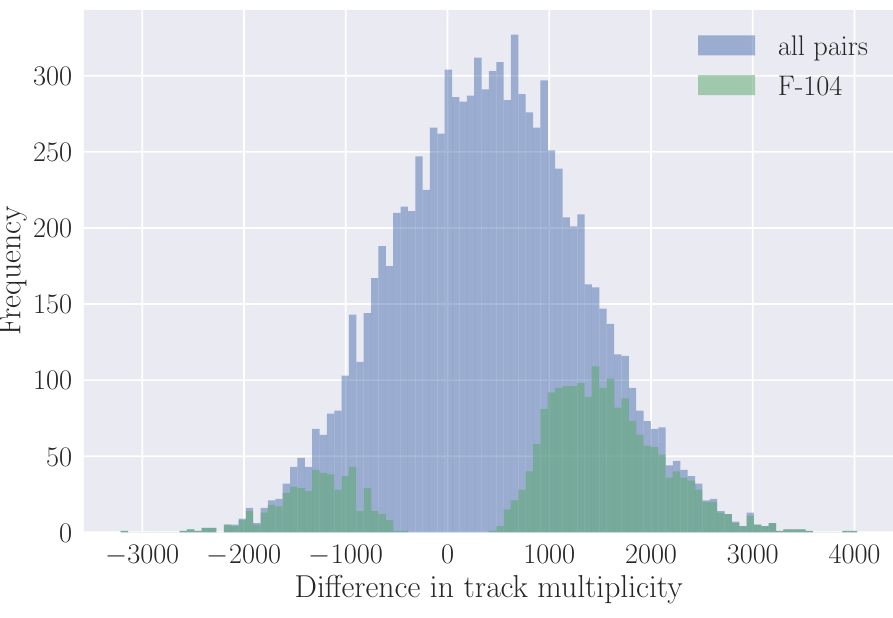
Figure 7 . (Color online) Distribution of the track multiplicity difference. The difference in the number of tracks is calculated for 10000 pairs of samples (first-order phase transition - crossover) and plotted in blue colour. The green color depicts the multiplicity difference of all the pairs of samples whose most important Feature is 104 (F-104). Most of the pairs with F-104 contain a significantly large number of tracks for first-order phase transition samples compared to crossover